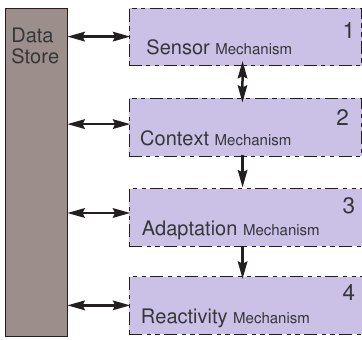
Figure 3. Architecture of Context-Aware